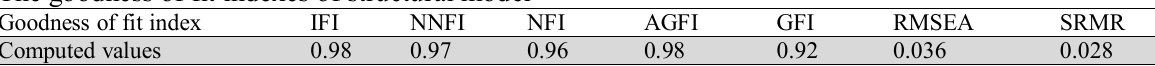
The goodness of fit indexes of structural